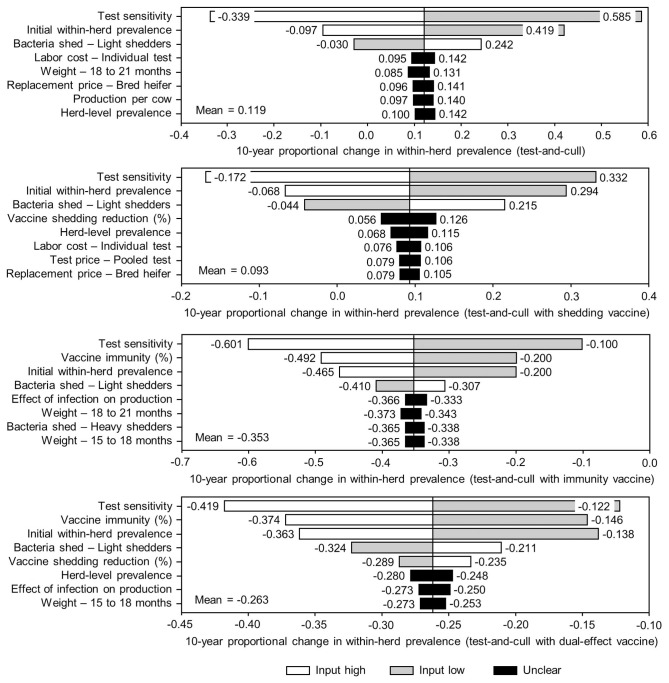
Sensitivity of 10-year proportional changes in within-herd Mycobacterium avium subsp. paratuberculosis (MAP) infection prevalence due to various JD (paratuberculosis) practices involving testing and culling to a range of input variables. Assumes initial mean values of 10% for within-herd MAP infection prevalence, 50% for herd-level prevalence, 50% for vaccine efficacies, and 50% for testing sensitivities. The color of the sensitivity bars indicates the direction of the relationship between the variable and 10-year proportional change in within-herd prevalence (grey indicates the effect of variable values below their mean value, white indicates the effect of values above their mean, and black indicates that the effect is unclear).